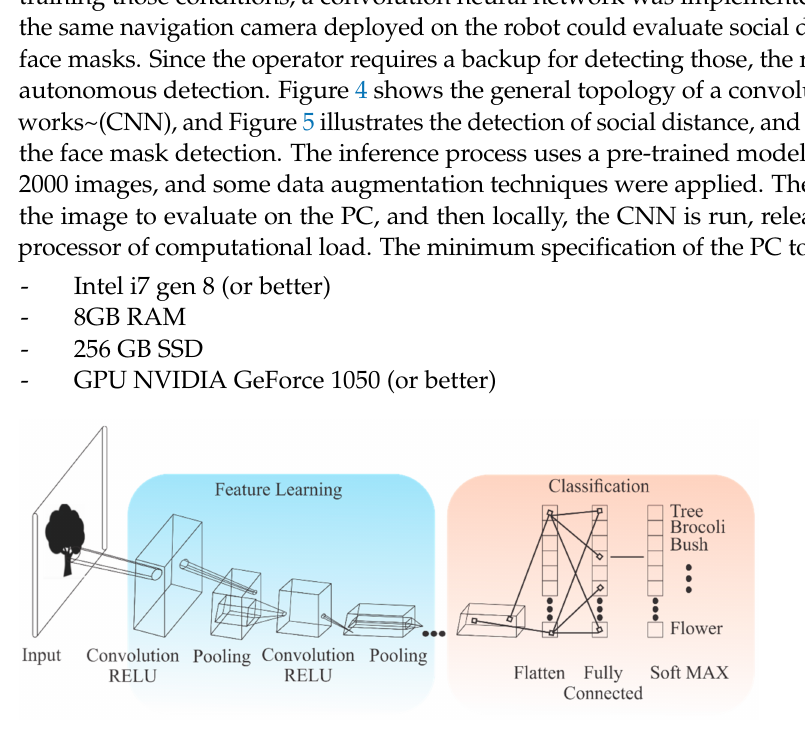
Figure 4. The general CNN topology, from the input to the classification result.